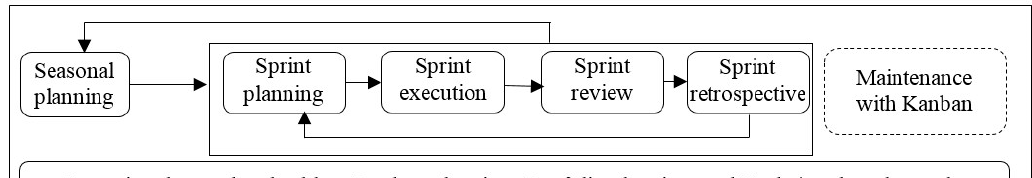
Figure 10. Overview of the proposed SPrL for A.